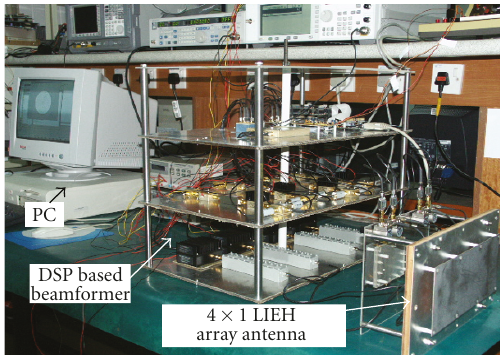
Figure 8: Constructed UKM testbed receiver system.